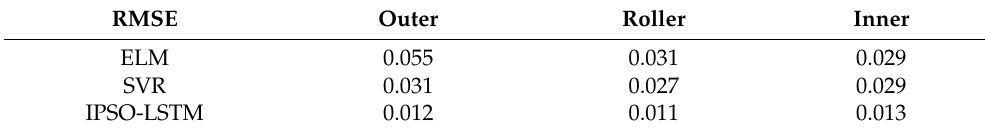
Table 4. The RMSE of different methods.